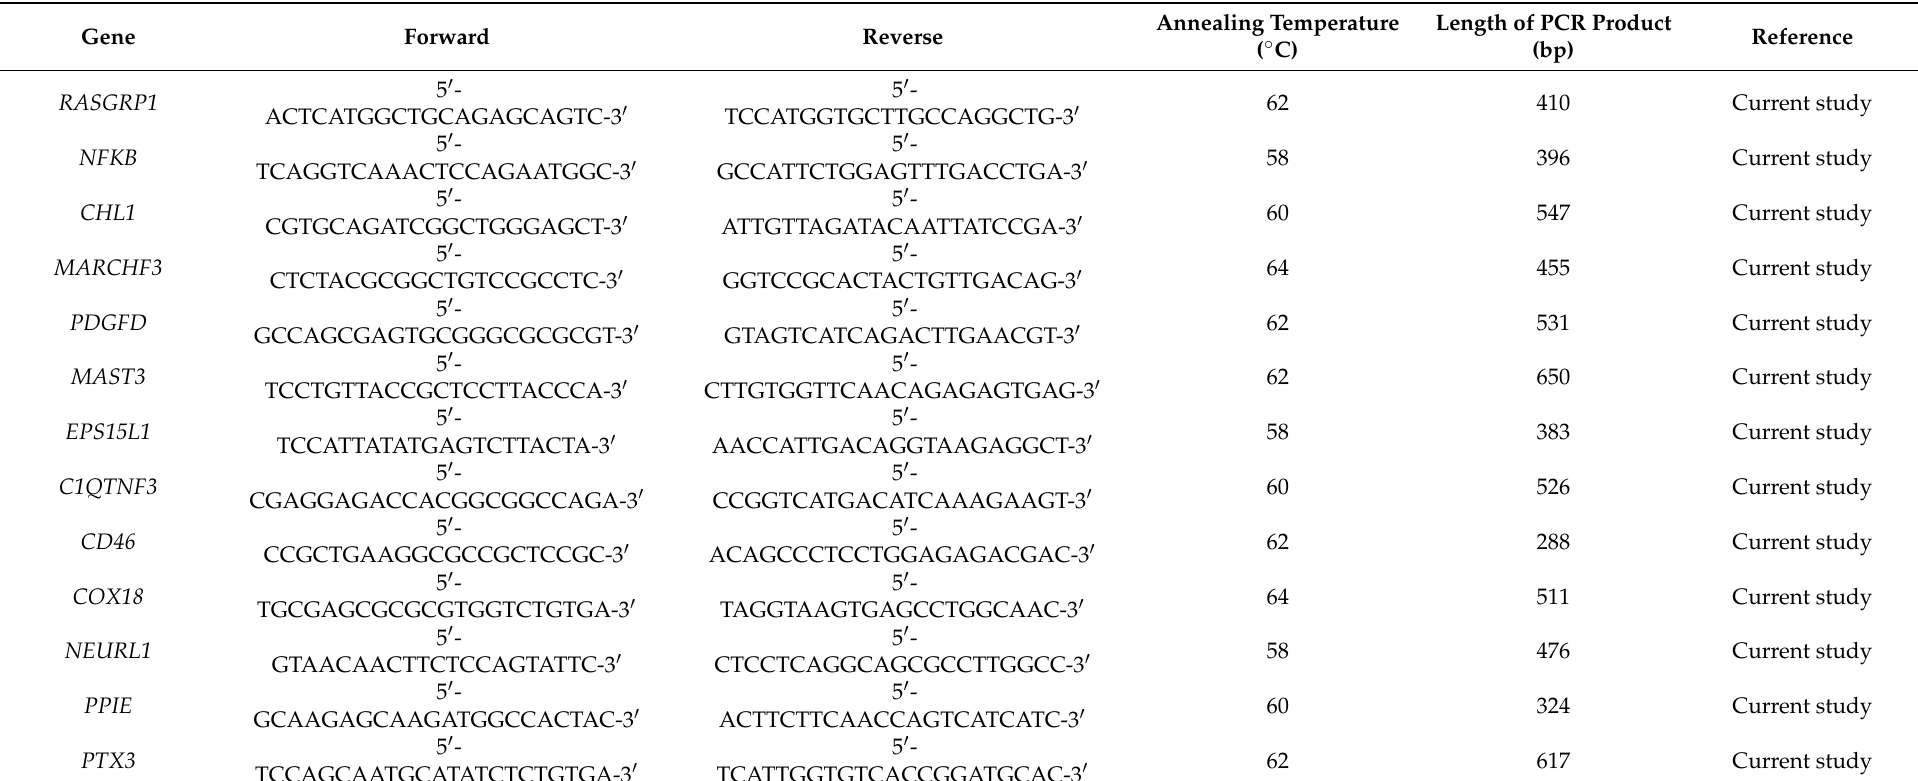
Table 1. Oligonucleotide primers sequence investigated genes utilized in PCR-DNA